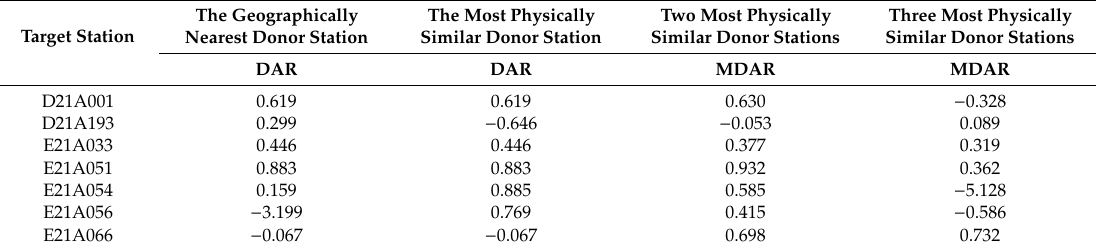
Table 12. NSE values for the DAR and MDAR methods in the Upper Euphrates Basin. Target Station